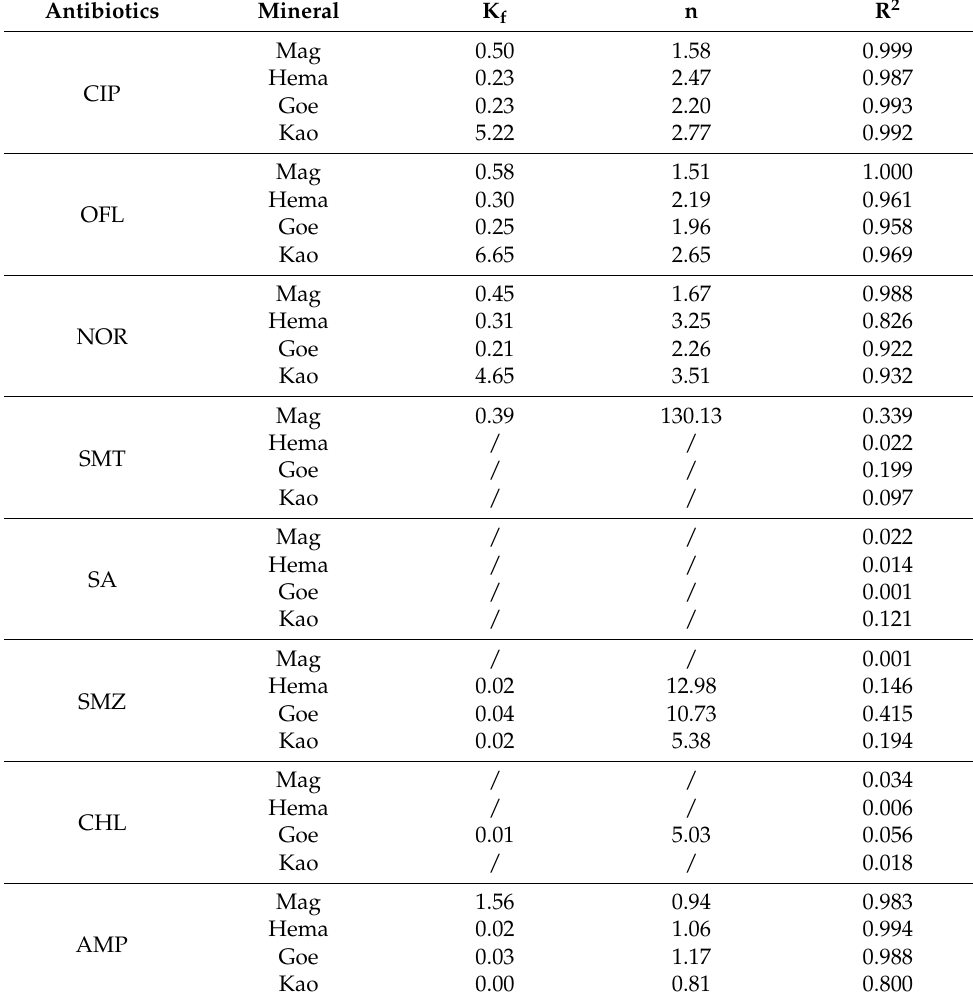
Table 2. Fitted parameters for different antibiotics adsorption